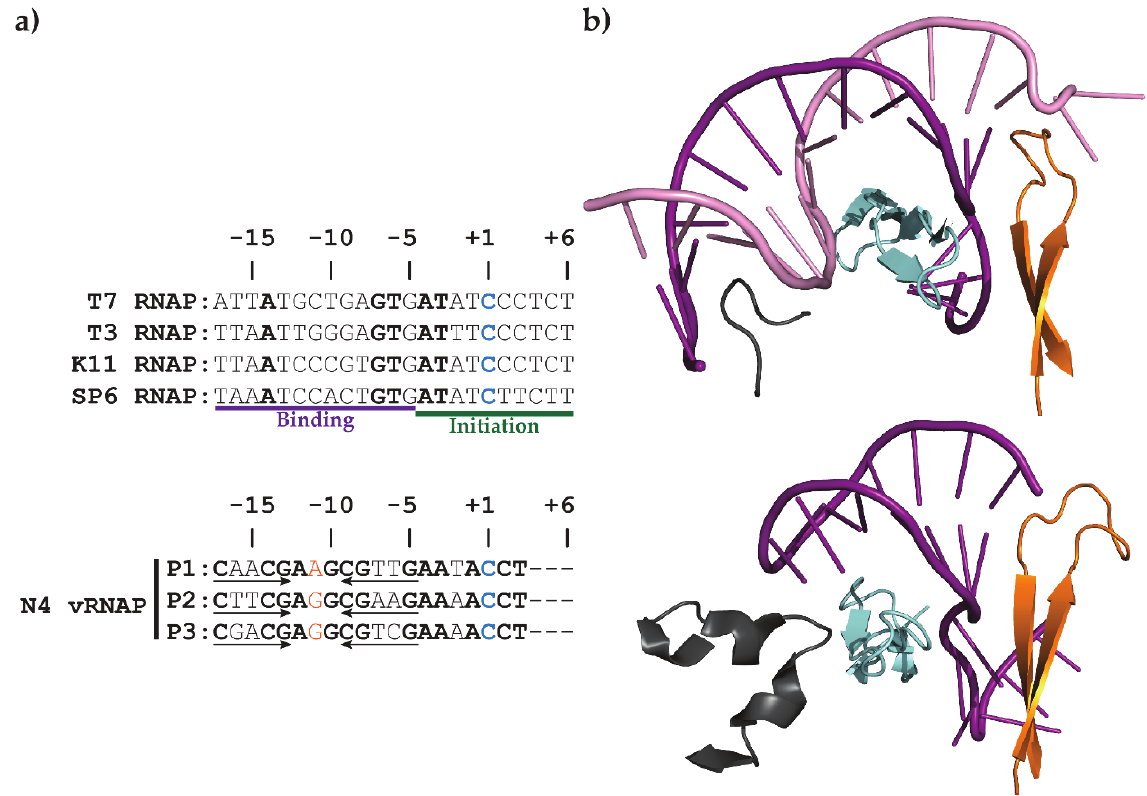
Figure 4. ( a ) Consensus promoter sequences of T7 and other related phage RNAPs compared with N4 vRNAP promoters. Template strand sequences spanning (cid:5)17 to +6 are shown relative to the transcription start site (+1) in 3' to 5' orientation. Bold: conserved bases in all promoters both within and across species. Blue: +1 nucleotide. Arrows: inverted repeats. Orange: central base of hairpin loop. Purple underline: (cid:5)17 to (cid:5)5 binding region. Green underline: (cid:5)4 to +6 initiation region. ( b ) Comparison of the three structural motifs responsible for promoter recognition between T7 RNAP (Accession number 1CEZ) (top) and mini-vRNAP (bottom). The AT-rich recognition site (T7 RNAP) and (cid:5)11 recognition element (mini-vRNAP) (grey) are responsible for recognition of upstream sequences. The specificity loops (cyan) recognize the promoter by sequence-specific contacts through the major groove. The (cid:3)-IH motif (orange) is responsible for defining the single-stranded to double-stranded DNA boundary. The template strand and non-template strand of promoter DNA are represented as purple and pink ribbons,